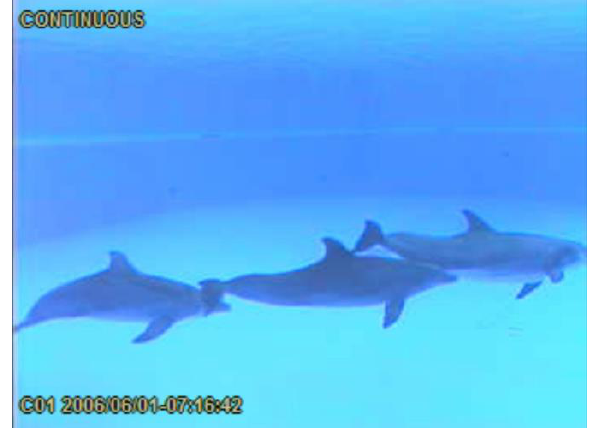
Figure 15 . Line Up (LU) animal 1 at the front with animals 4 and 5 behind